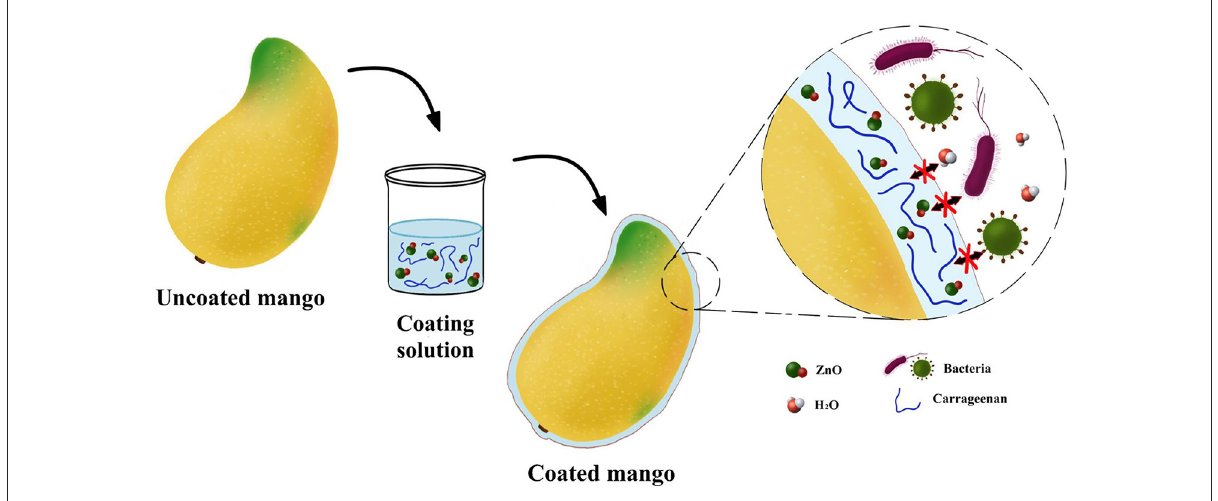
FIGURE7 Schematic diagram of the application of the carrageenan-ZnO nanocomposite coating for mango